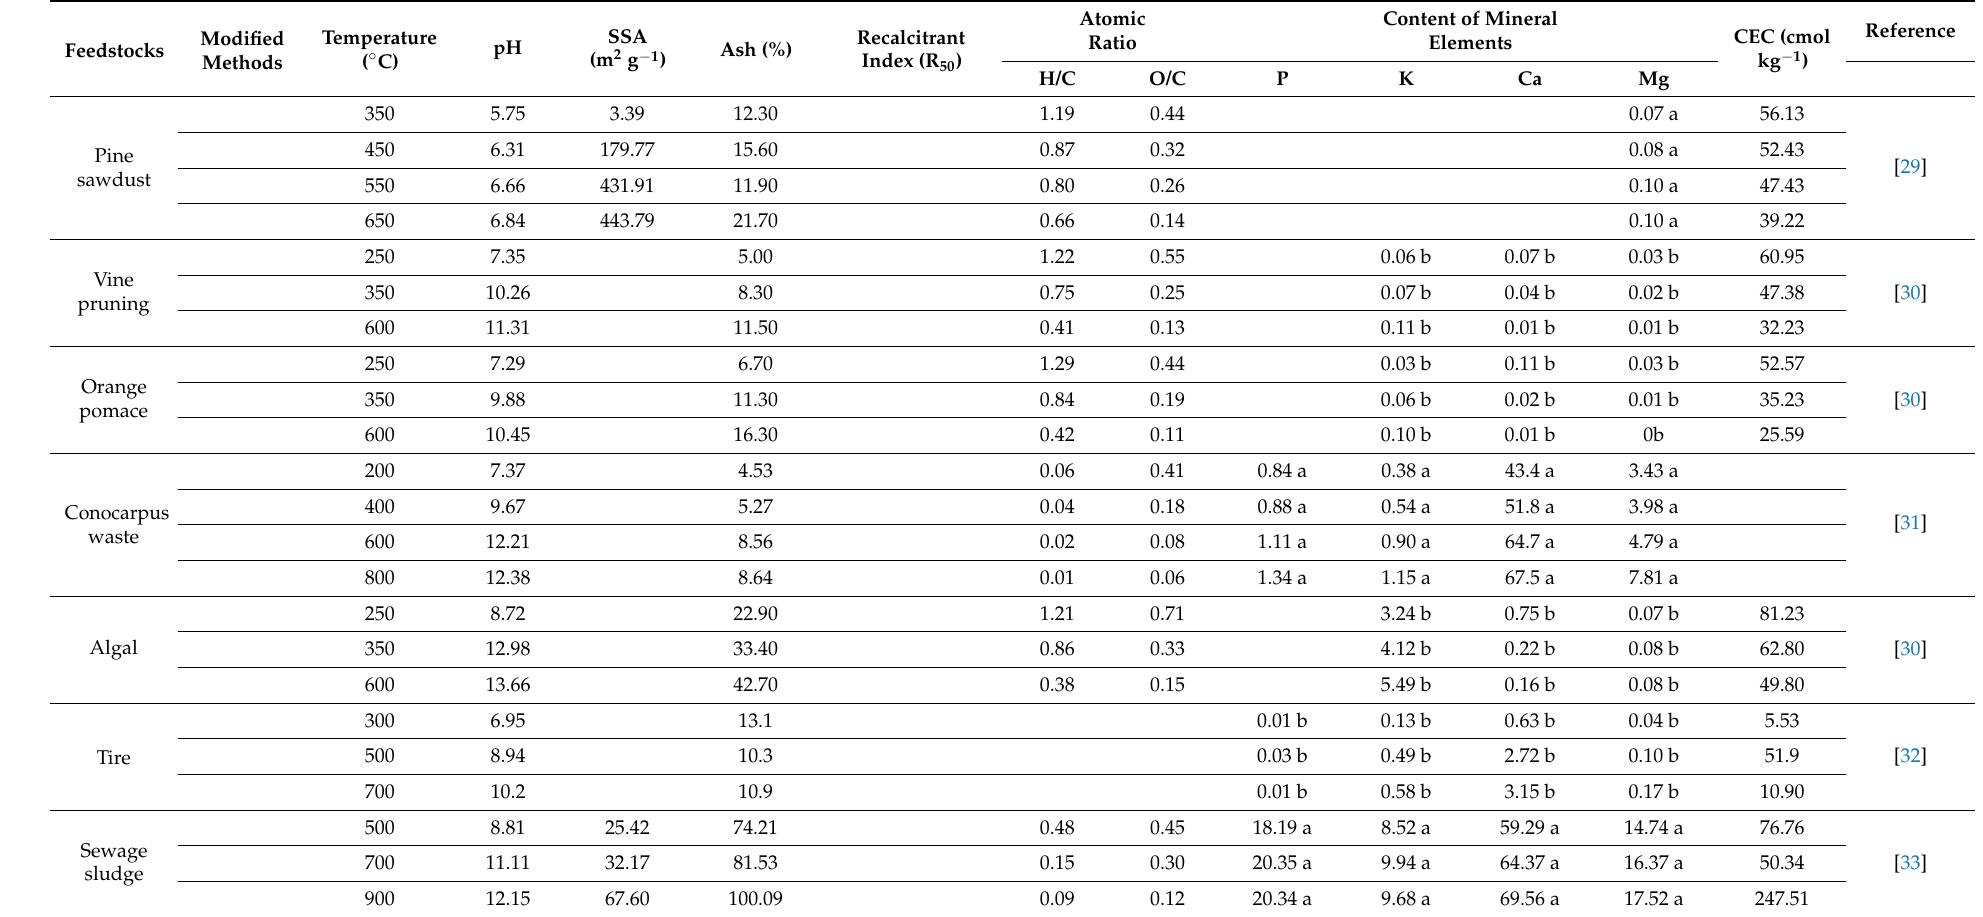
Table 1. Effects of feedstock type, pyrolysis temperature, and modification method on the performance characteristics of